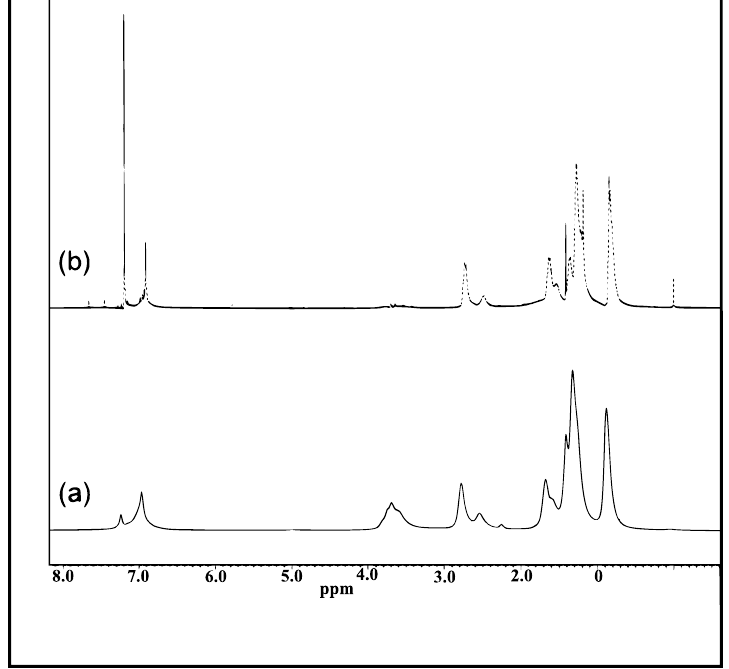
Figure Figure 1. 1 H-NMR spectra of ( a ) poly(3-hexylthiophene- co -methyl 2-(thiophene-3-yl)acetate (P(3HT- co -MTA)) and ( b ) P(3HT- co -3TAA).